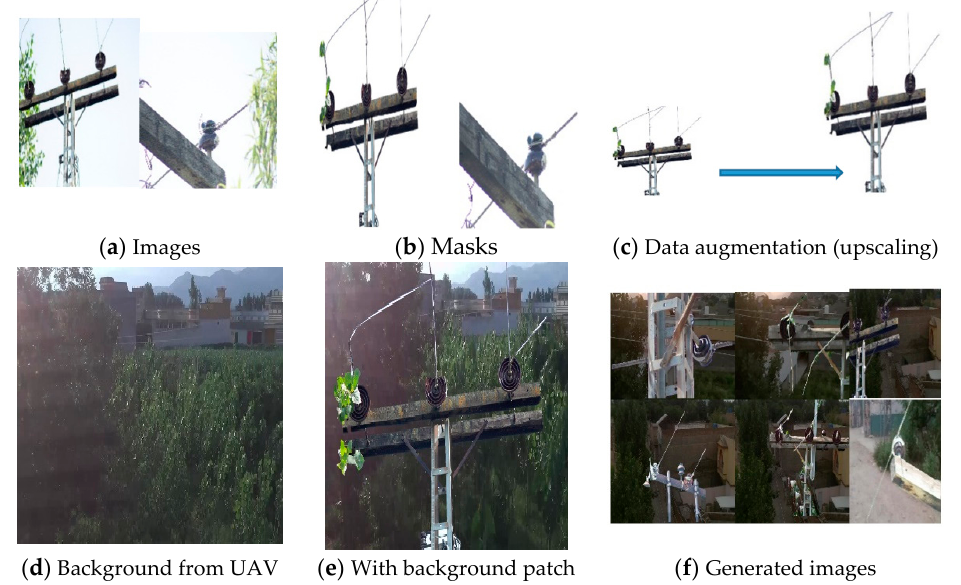
Figure 8. Steps of dataset formation from ( a – e ).